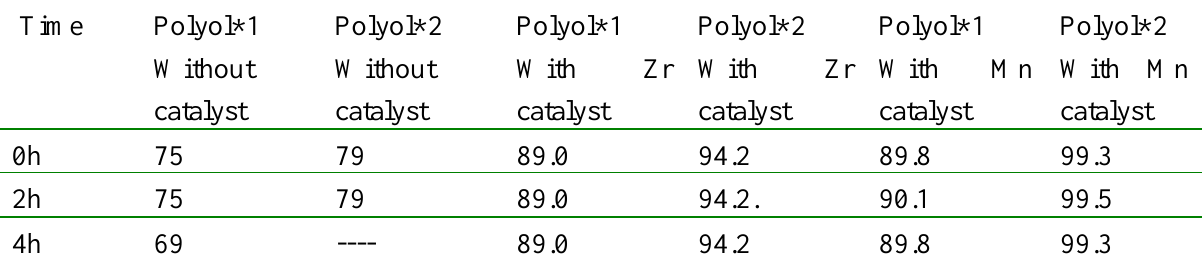
Table 3 . Measurements of the gloss with the increasing induction time (applied on a glass plate,